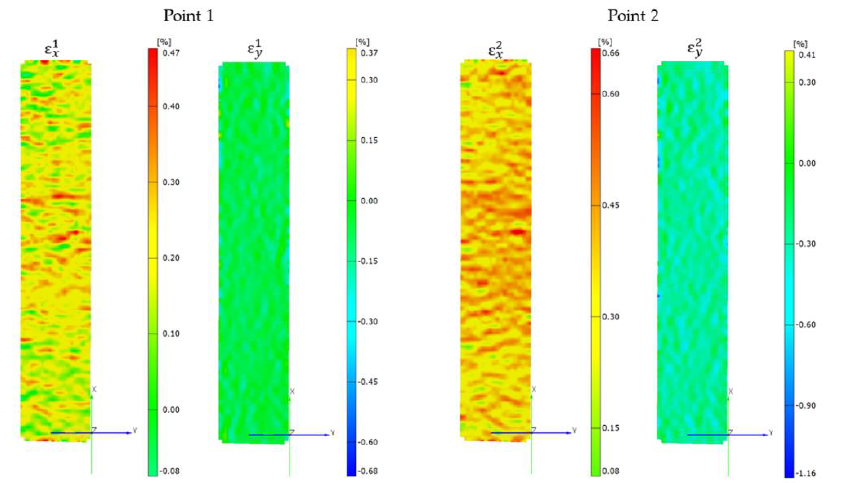
Figure 10. Representative longitudinal and transverse strains fields for two measurement points with a shear strain of 0.002 and 0.005, respectively.